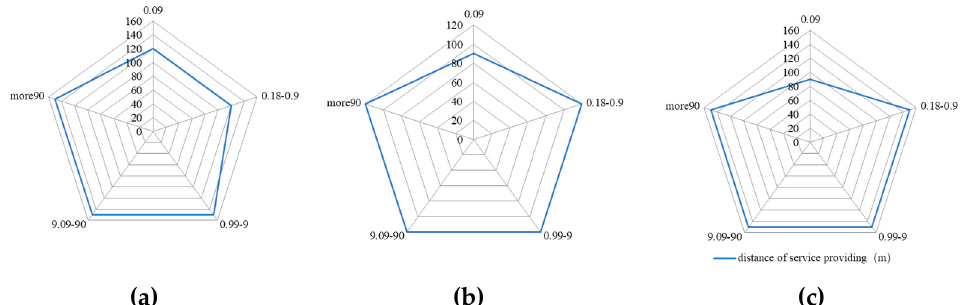
Figure 3. Radar diagram of the supply distance of the “source” landscape on the temperature regulating service in ( a ) 2005, ( b ) 2010, and ( c ) 2013 under different patch sizes.